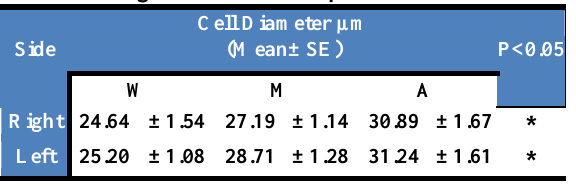
Table, 3: Number of sensory neurons diameter (µm) at level L6 segment of rabbits spinal cord.